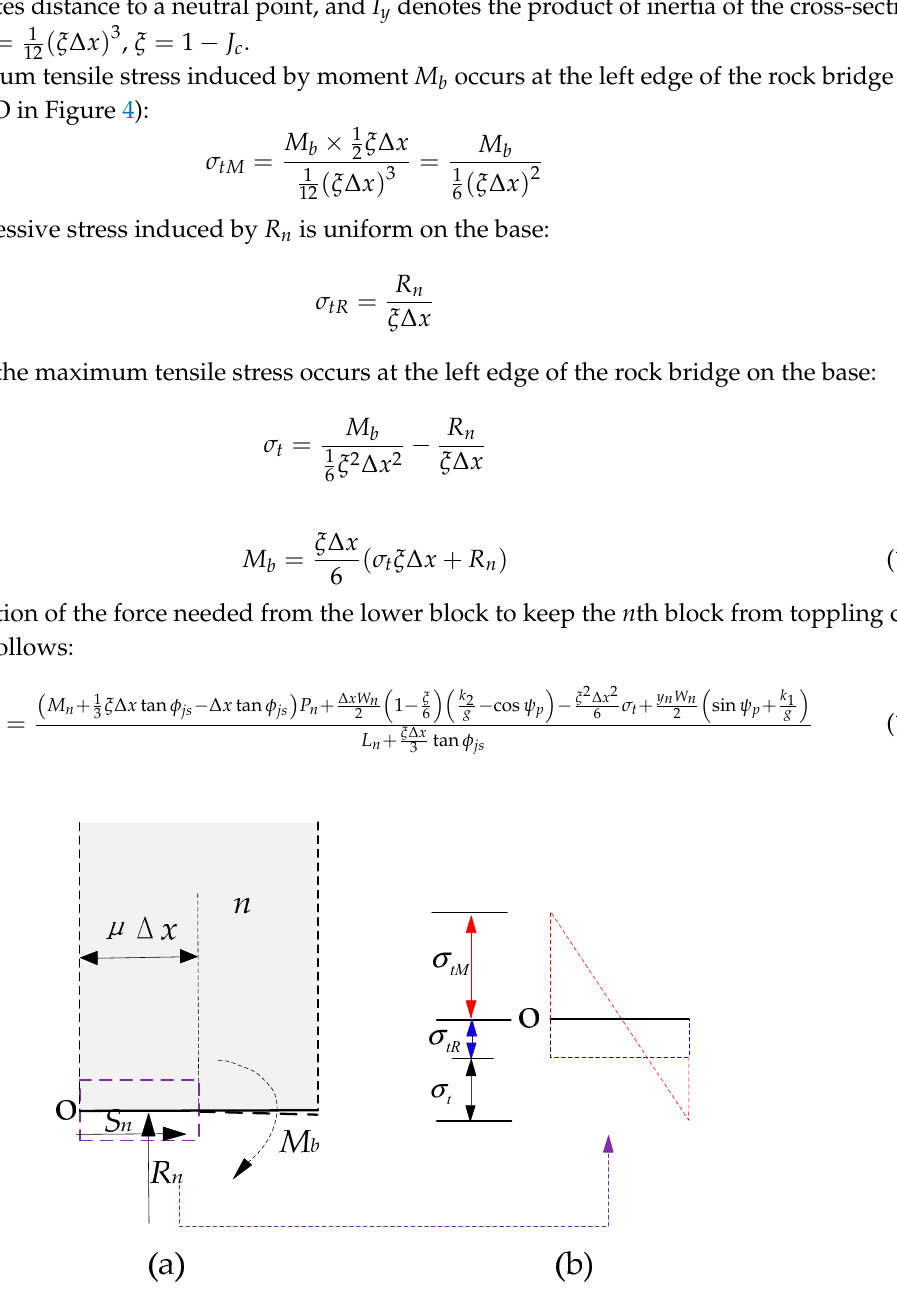
Figure 4. The toppling mechanical condition on the base with non-persistent joint (Modified based on [1]): ( a ) the mechanical condition of the block base; ( b ) the stress distribution along the block base. The dynamic loads as well as joint connectivity rate are taken into account in the limit equilibrium method compared with the original form proposed by [8]. For the special state of static conditions and a persistent block base, the limit equilibrium Equation (4) of sliding and Equation (11) of toppling would be simplified as Equations (12) and (13) respectively. Equations (12) and (13) are the same as the original form proposed by [8]. It can be seen that the proposed solutions are a universal form that can estimate the deformation status and factor of safety (FOS) for toppling slope with various J c of the block base under different seismic loads. (